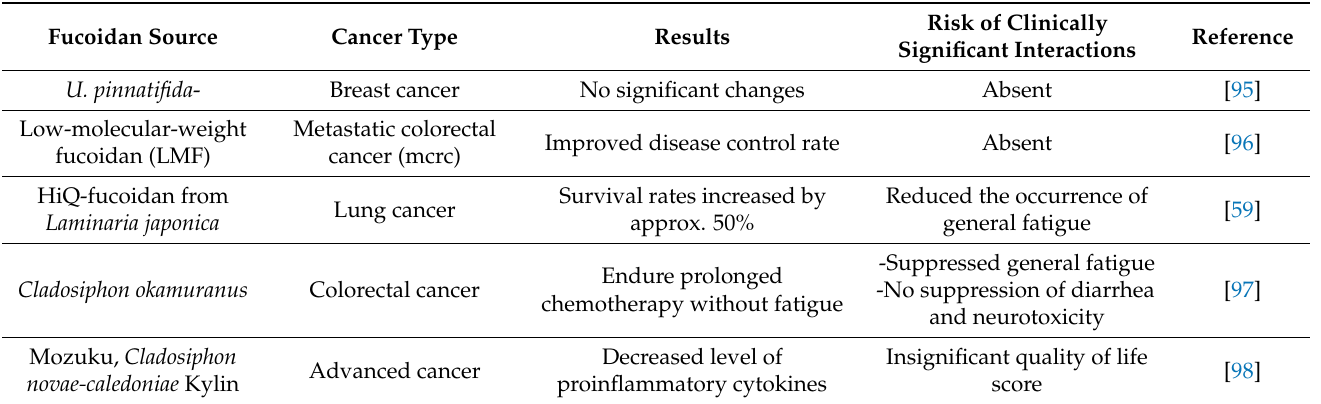
Table 1. Case studies of fucoidan in alternative medicine and complementary therapy: human clinical trials.